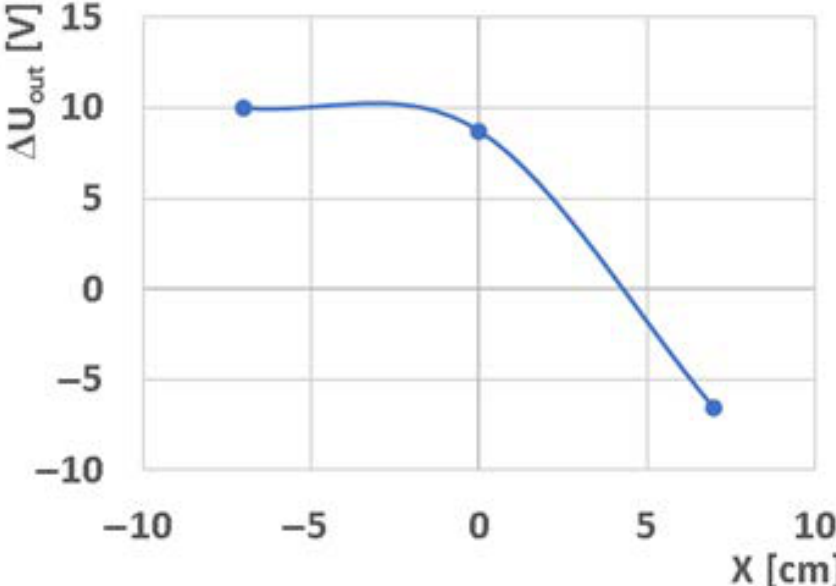
position TDS1 (approx. 3 cm below the top level) water pouring position (quantity specified in the article) position TDS2 (approx. 3 cm below the top level) Figure 5. Changes in the output signal of the U out thermodynamic system with fixed sensors at three different positions of hot water addition.